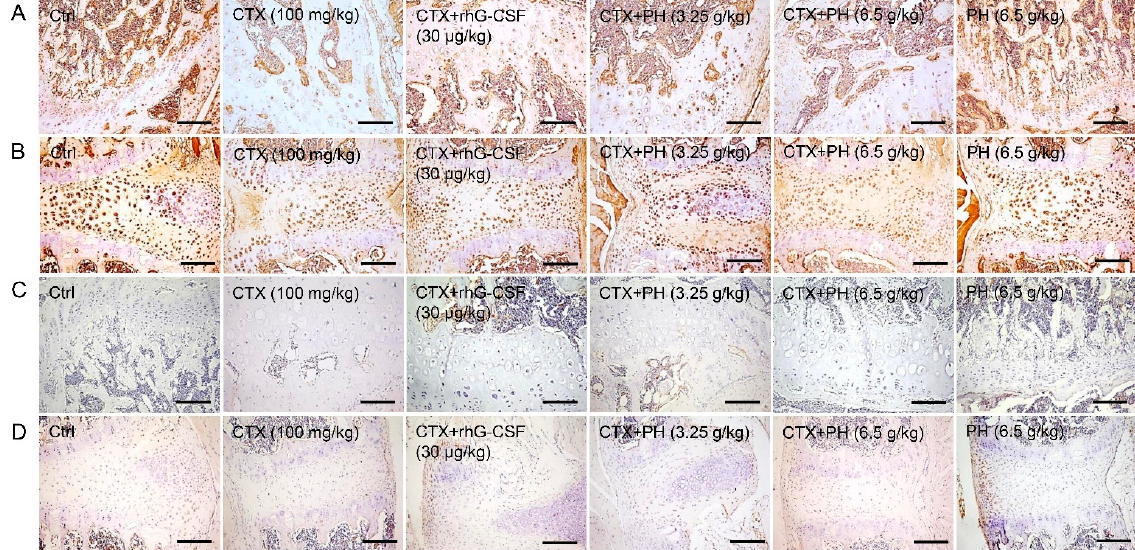
Figure 4. Histopathological observations of sternum and femoral condyles of mice with hematopoietic dysfunction. PH enhanced the expression levels of IL-2 in ( A ) femoral condyle and ( B ) sternum, but no positive staining of M-CSF was noted in ( C ) femoral condyle and ( D ) sternum detected by immunohistochemical staining under a light-microscope digital camera (100 × , scale bar: 200 µ m) ( n = 3 mice/group in triplicate). CTX, cyclophosphamide; Ctrl, control; Model, hematopoietic dysfunction model; rhG-CSF, recombinant human granulocyte colony-stimulating factor; PH, Protein hydrolysate injection; M-CSF, macrophage colony stimulating factor; IL-2, interleukin-2.